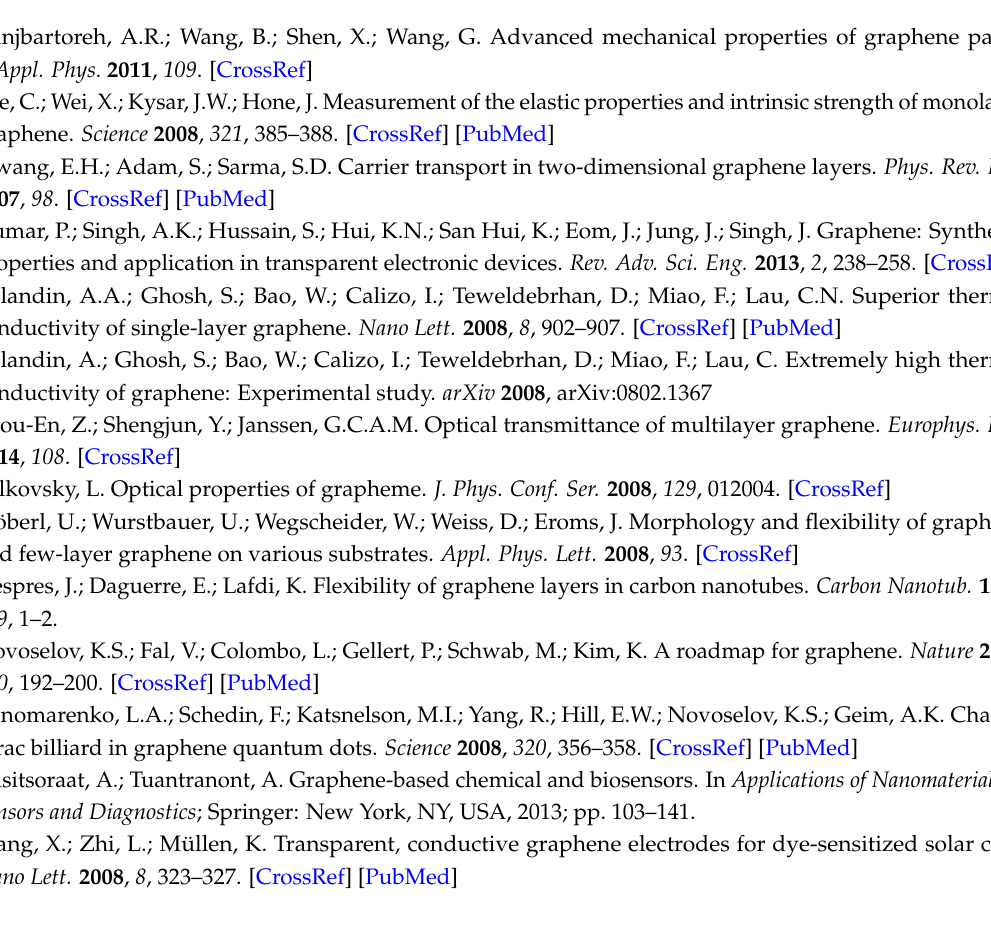
Figure S1: Raman spectroscopy for the as received CVD monolayer